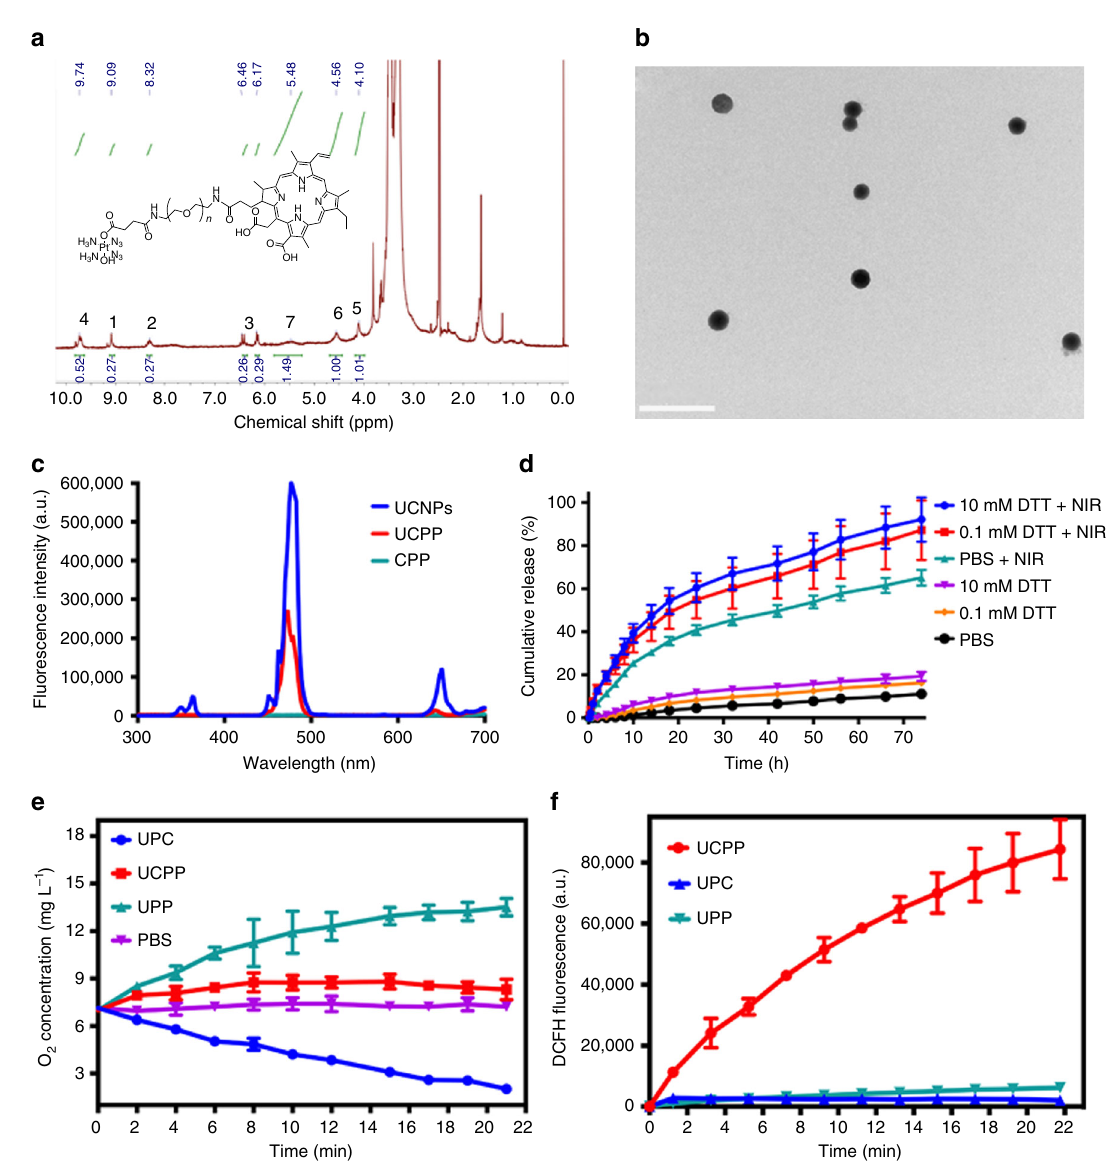
Fig. 2 Characterization of UCPP. a 1 H NMR spectrum of prodrug CPP; b TEM image of UCPP. Scale bar = 0.5 μ m; c Emission spectra of pure UCNPs (blue line), UCPP (red line) and pure CPP (green line) under 980 nm laser; d Pt release from UCPP in different concentrations of DTT buffers under dark or NIR irradiation.; e Oxygen generation or consumption of UPP, UCPP and UPC under 980 nm irradiation (0.85 W cm − 2 ); f The generation of ROS of UCPP, UPP or UPC under 980 nm irradiation (0.85 W cm − 2 ) in hypoxia environment, determined by the fl uorescence intensity of DCFH. Data were shown as mean ± S.D. ( n =